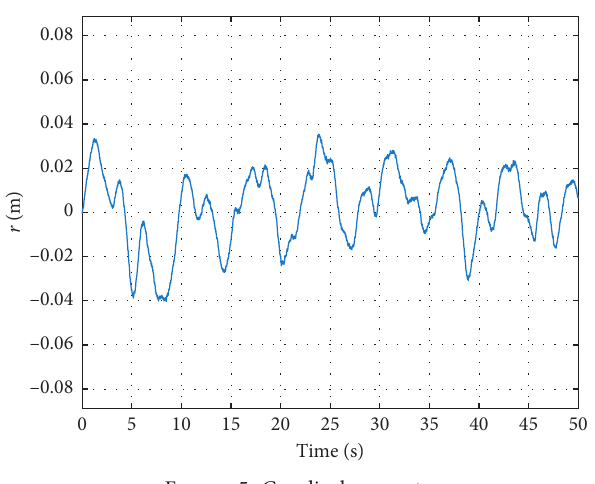
Figure 7: Swing rod 2